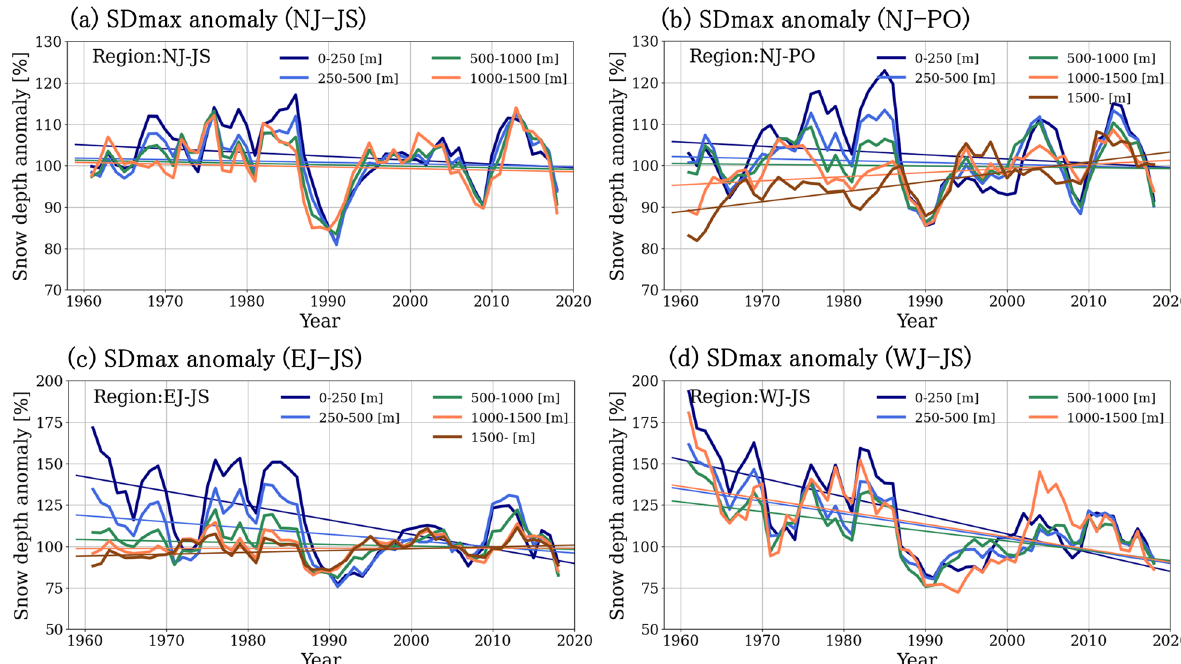
Fig. 8 Annual variations and linear trends of SDmax anomalies relative to 1991–2000 at 0–250 m (blue line), 250–500 m (light blue line), 500– 1000 m (green line), 1000–1500 m (orange line), and over 1500 m (brown line). The straight lines represent linear